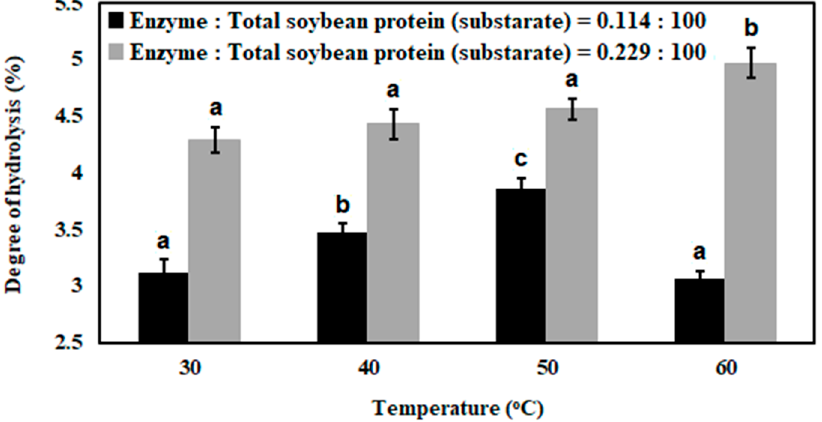
Figure 3. Degree of hydrolysis of soybean milk proteins with different concentrations of papain and hydrolysis temperatures.